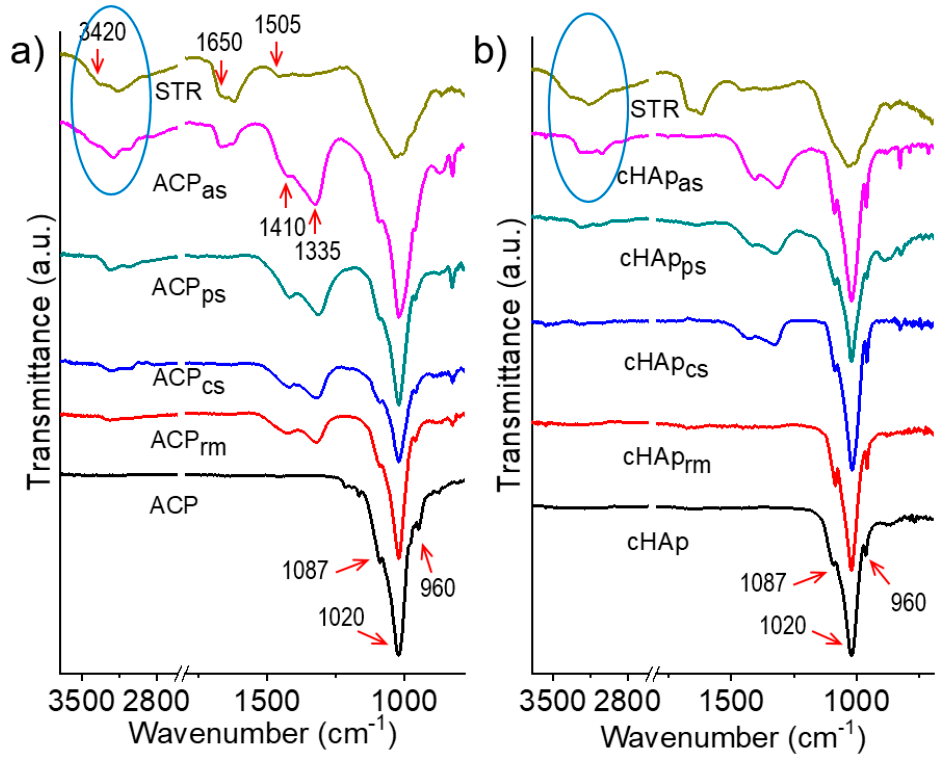
Figure 4. FTIR spectra of unloaded and STR-loaded ACP ( a ) and cHAp ( b ) nanoparticles. The X-ray powder diffraction (XRD) patterns of the different nanoparticles are shown in Figure 5. The diffraction profiles were identical when the unloaded and STR-loaded samples were compared, even at the higher amounts of incorporated STR (i.e., the samples obtained by adsorption). In fact, the STR profiles where characterized by the presence of two amorphous halos at 0.434 and 0.346 nm, which were not relevant in the profiles